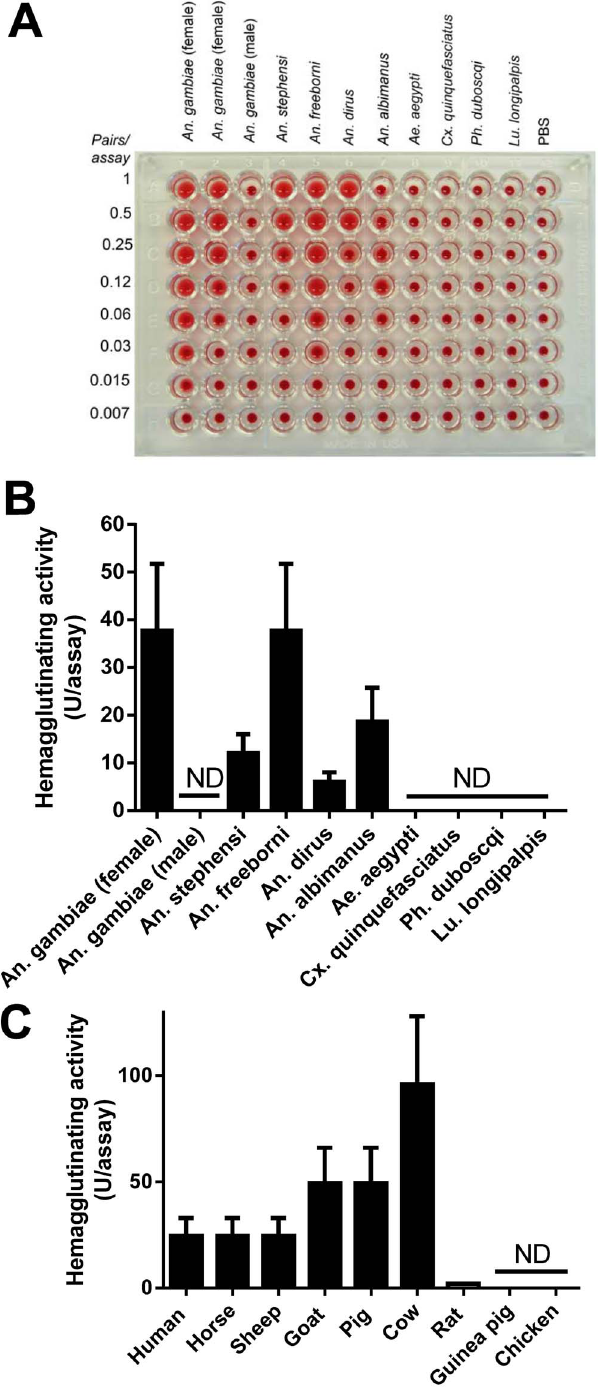
Figure 1. Lectin activity for the SGH of Anophelinae mosqui- toes, but not for other genus. (A) SGH from An. gambiae (male and female), An. stephensi, An. freeborni, An. dirus, An. albimanus, Ae. aegypti, Culex quinquefasciatus, Phlebotomus duboscqi, Lutzomyia longipalpis, were serially diluted followed by addition of O-type RBC. Two preparations of female An. gambiae SGH were tested. (B) Quantification of lectin activity. U/assay was given as 1/ n , where n is the maximum dilution promoting agglutination presented in (A) ND, not detected. (C) Species-specificity. SGH of An. gambiae was tested in RBC from human, horse, sheep, goat, pig, cow, rat guinea pig, and chicken.